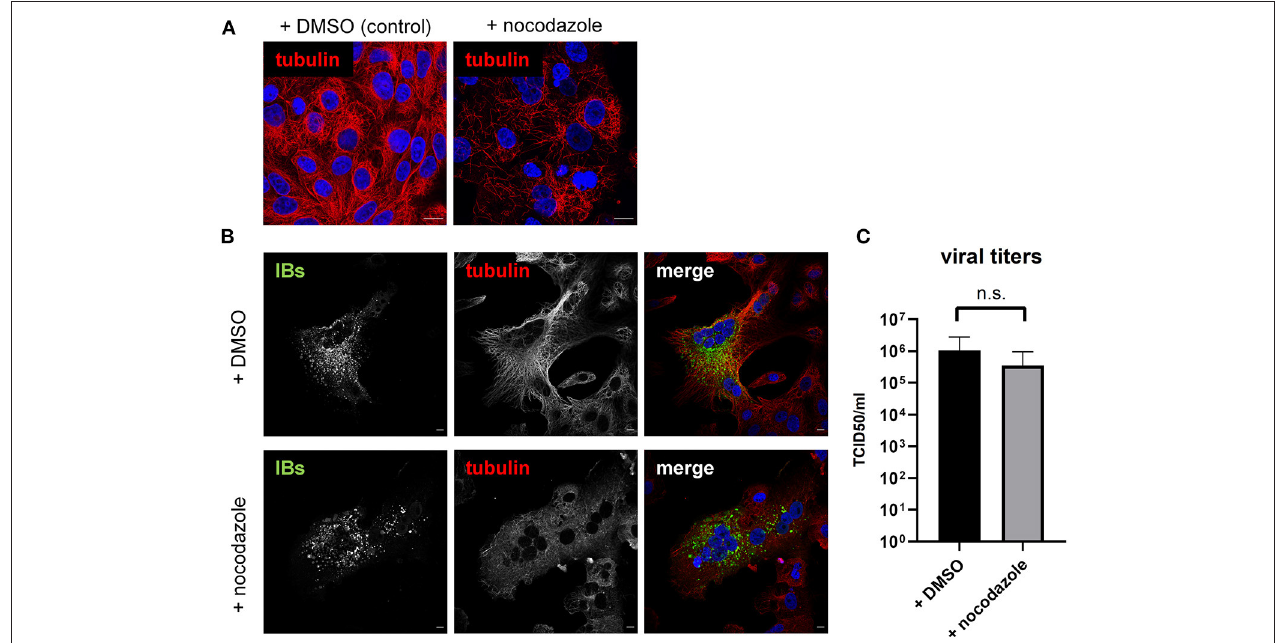
FIGURE 6 | Influence of MT disruption on IB formation and NiV replication. (A) Vero76 cells were treated with 250nM of nocodazole. After 18h the cells were fixed with 4% PFA and permeabilized with Triton X-100. α -tubulin was detected with specific antibodies (red). (B) Vero76 cells were infected with NiV at an MOI of 0.05 and treated with 250nM nocodazole. 18h p.i. cells were fixed with 4% PFA for 10min and permeabilized with Triton X-100. α -tubulin was labeled with specific antibodies (red). Cell were fixed with 4% PFA for 48h and stained with a NiV N antiserum to visualize IBs (green). Nuclei were counterstained with DAPI (blue). Scale bars, 10 µ m. (C) Vero76 cells were infected with NiV at an MOI of 1 and treated with 250nM nocodazole. 18h p.i. supernatants were harvested and viral titers were determined. Error bars indicate standard deviation (SD); n.s., not